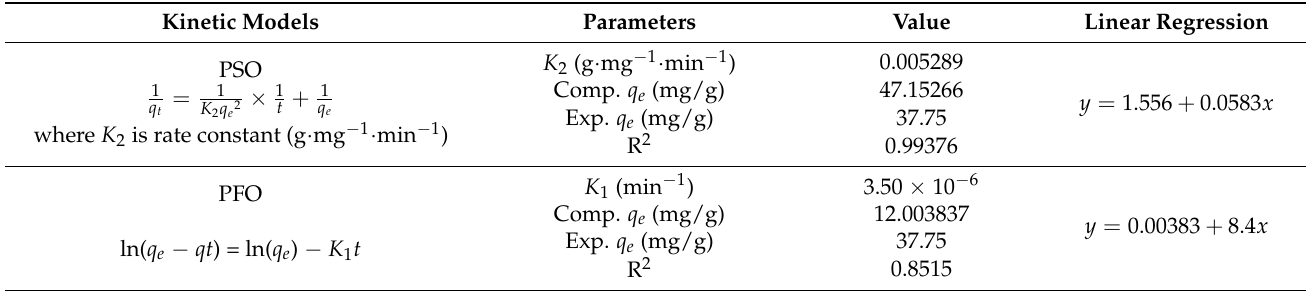
Table 5. Kinetic study result for BPA